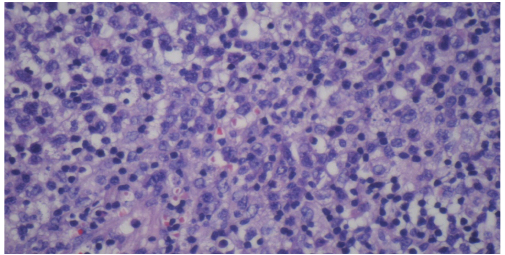
Figure 4: Rectal ulcer biopsy under high magnification shows atypical large and medium hematopoietic cells with large irregular nuclei and pale cytoplasm. Scattered small lymphocytes and plasma cells also seen.